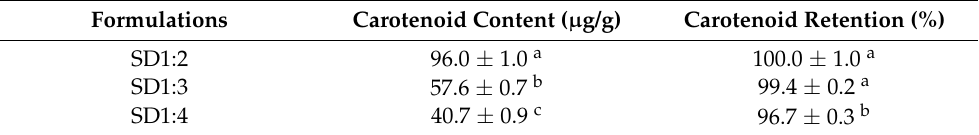
Table 2. Total carotenoid content and retention in microparticles after the spray drying (SD) process. Formulations